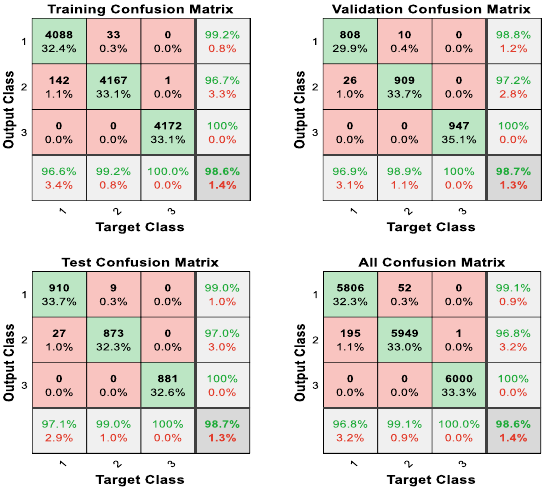
Fig. 13 Confusion matrix of the developed machine model on the 29-bus system